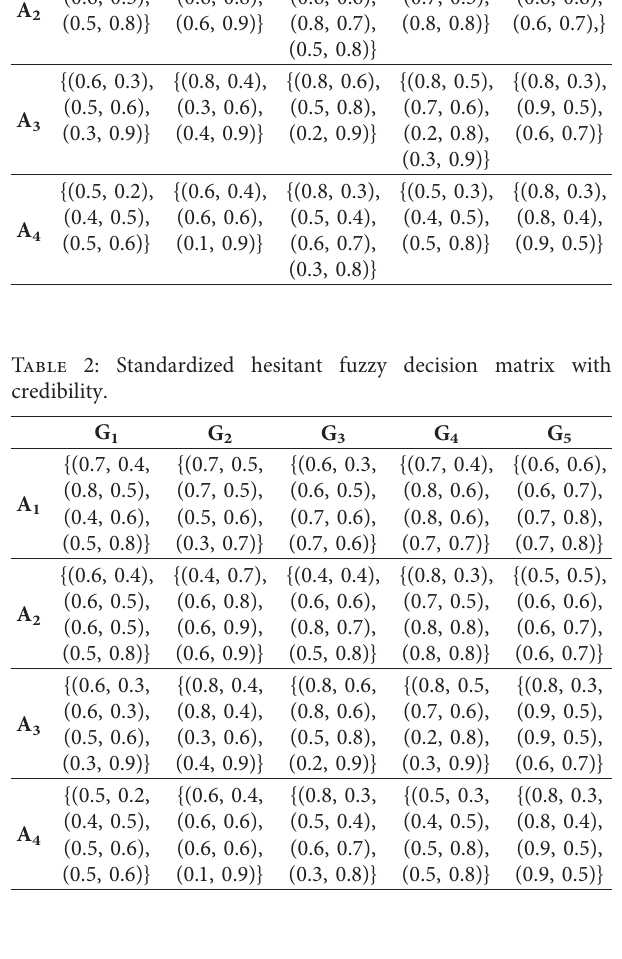
Table 3: Values of attribute comprehensive decision after infor- mation integration.